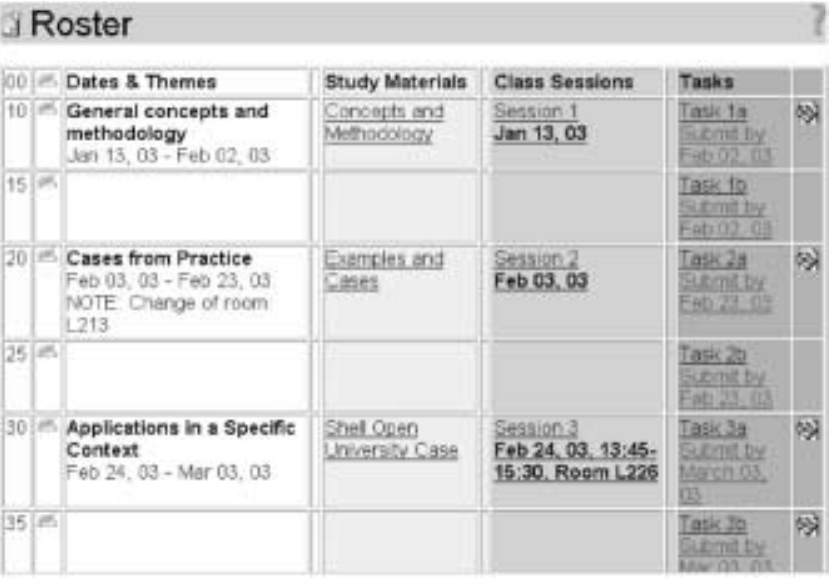
Figure 5. Options in tasks for students: Choose the ‘a’ or ‘b’ variant Case studies: interpersonal flexibility